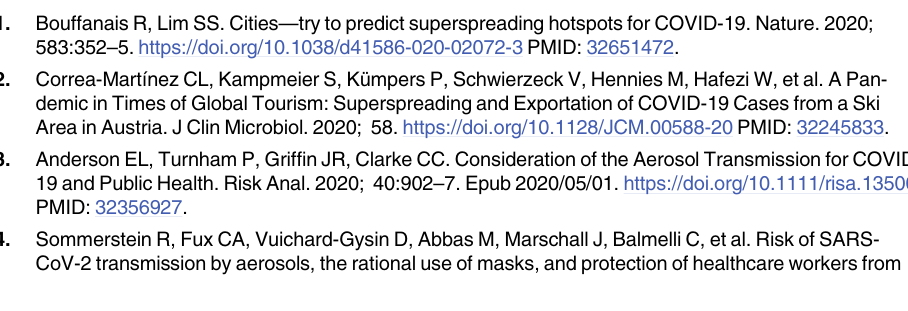
S1 Table. Individual test